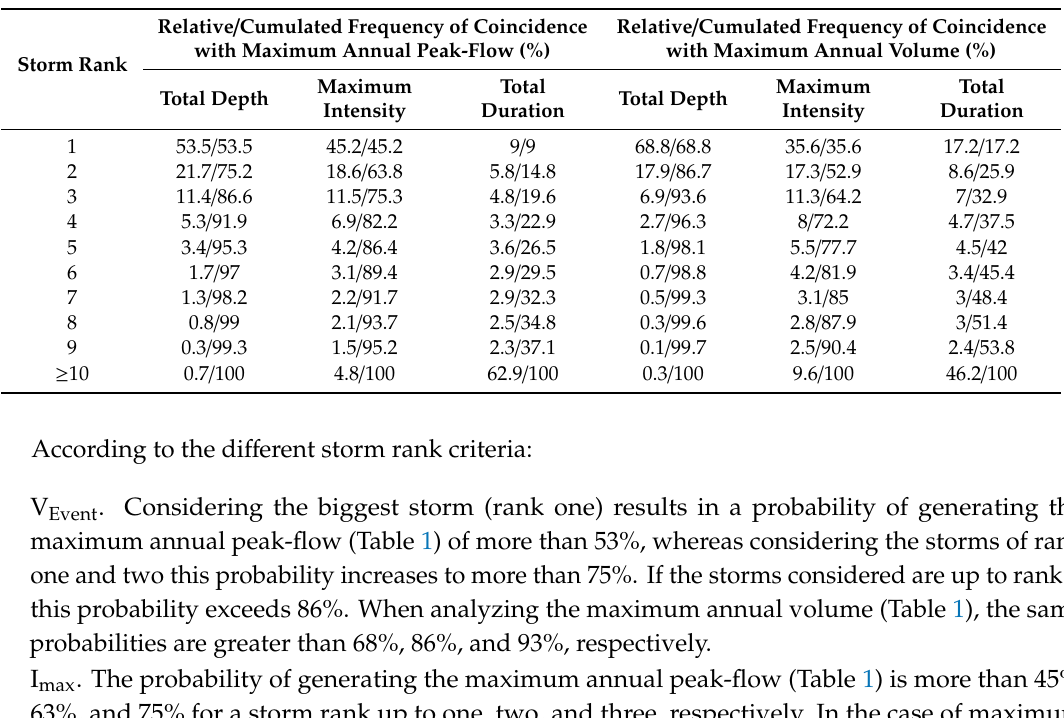
Table 1. Relative and cumulated frequency that a storm of a specific rank generates the maximum annual peak-flow and the maximum annual volume.